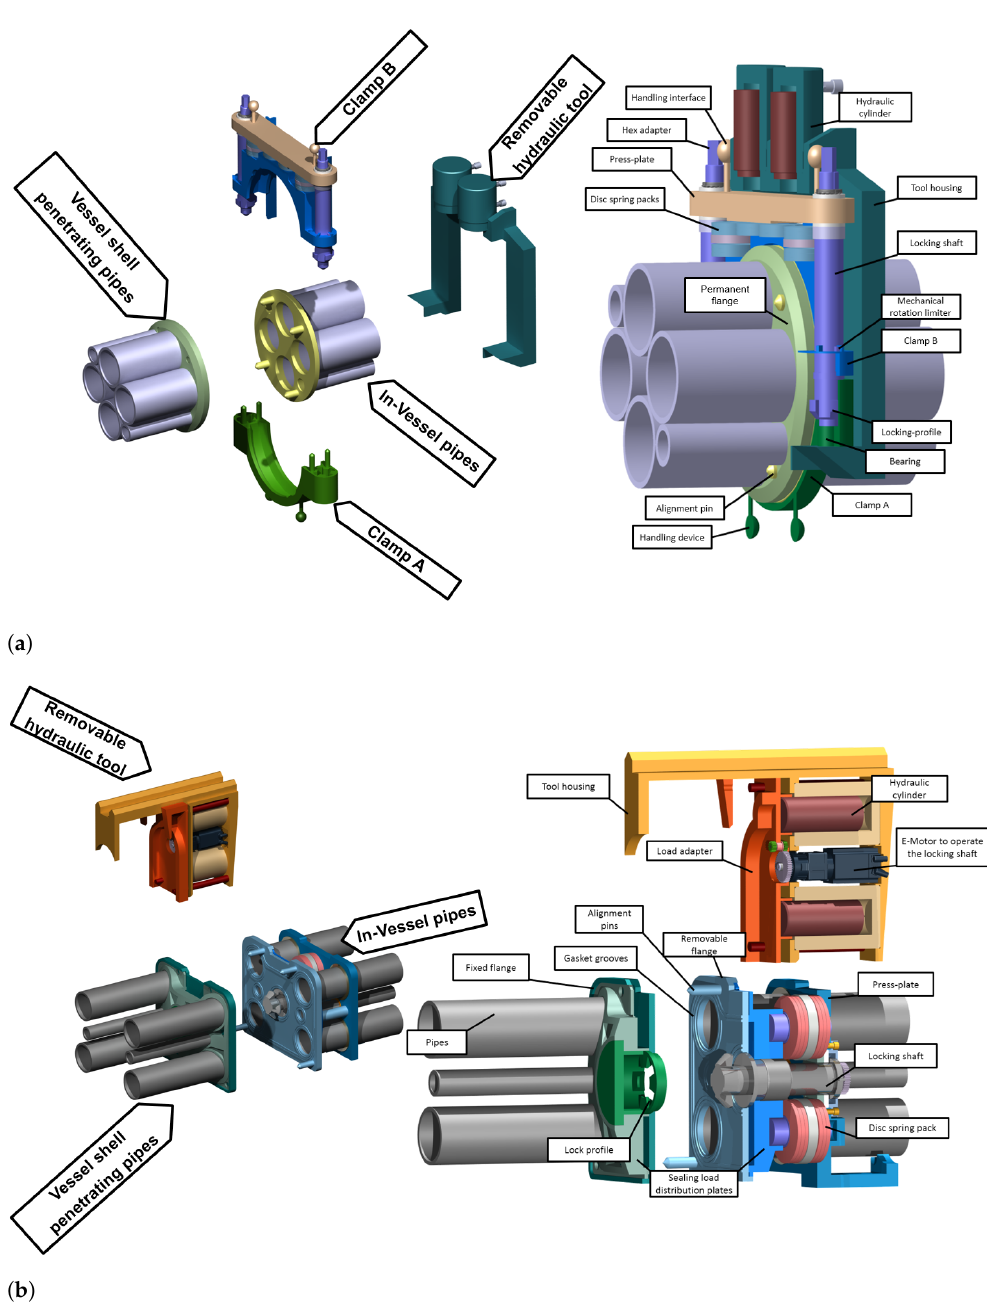
Figure 1. Two concepts of manifold pipe connection for DEMO. ( a ) Hub and Clamp Connection. ( b ) Compact-Flange